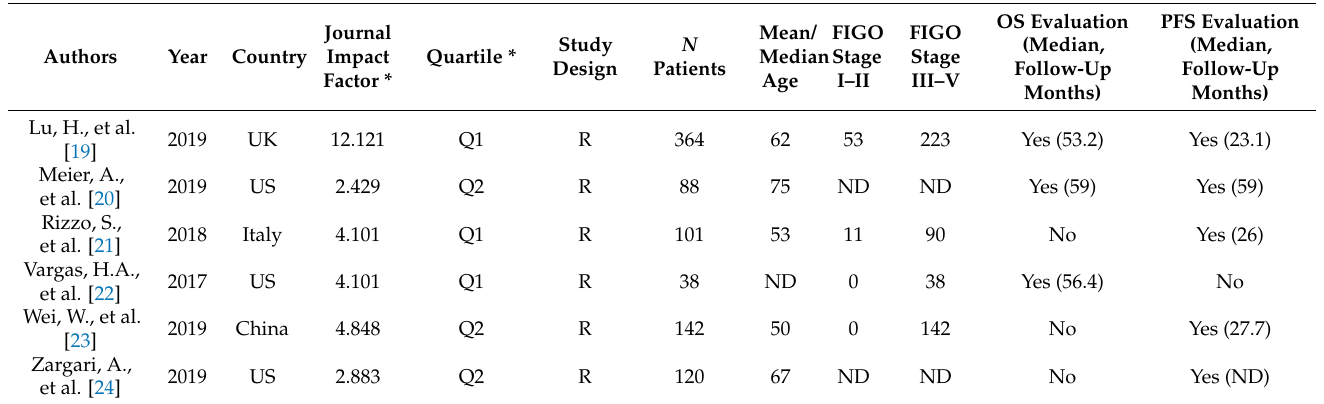
Table 1. Basic Study and Patient Characteristics.